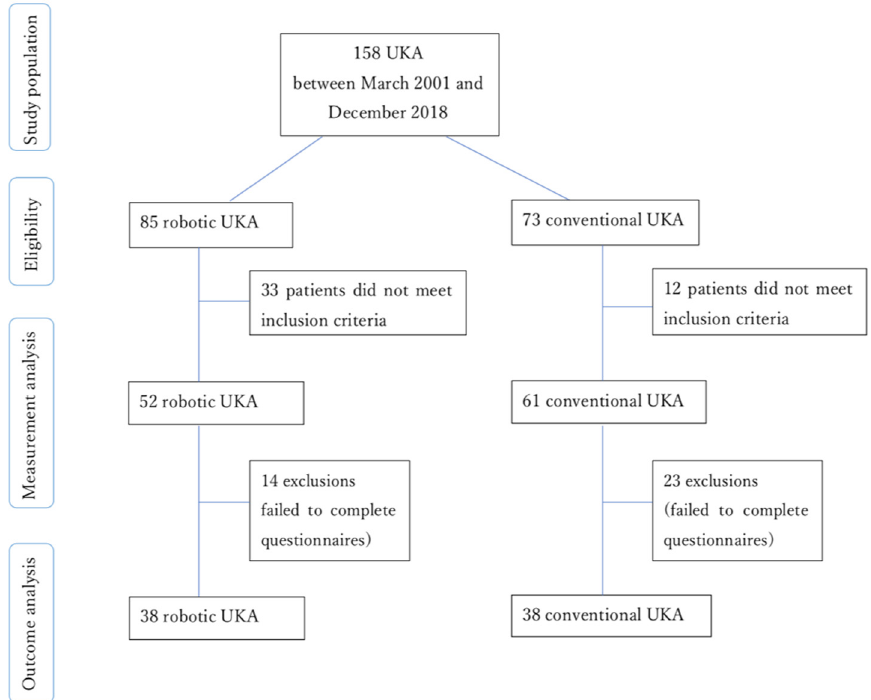
Figure 1. Flowchart of the retrospective cohort study on CUKA and RUKA. Abbreviations: CUKA, conventional unicompartmental knee arthroplasty; RUKA, robotic unicompartmental knee arthroplasty.